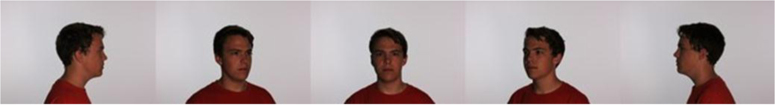
Photos of five different positions were taken for every set.